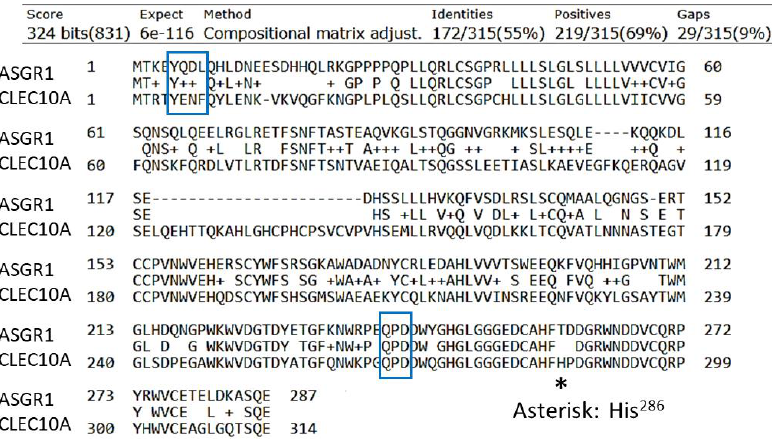
Figure 1. Comparison of the sequences of CLEC10A (isoform 1) and ASGR1. CLEC10A has two additional amino acids at the C-terminus, SH. ASGR1 has four additional amino acids, PPLL, at the C-terminus. The endocytosis motif (positions 5 to 8) and the QPD sequence that correlates with specificity for Gal / GalNAc are